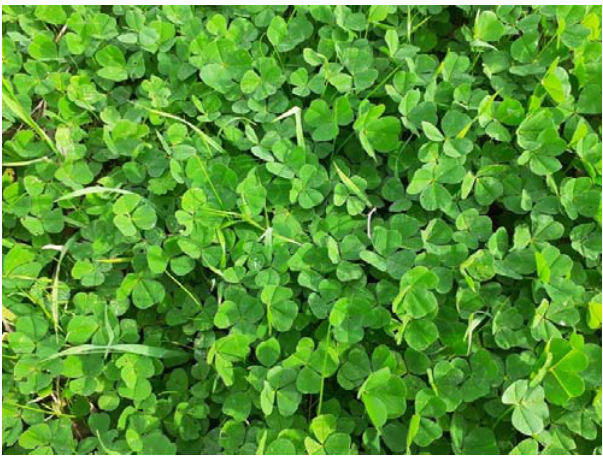
Figure 2. Trifolium subterranean TS007 at vegetative stage.